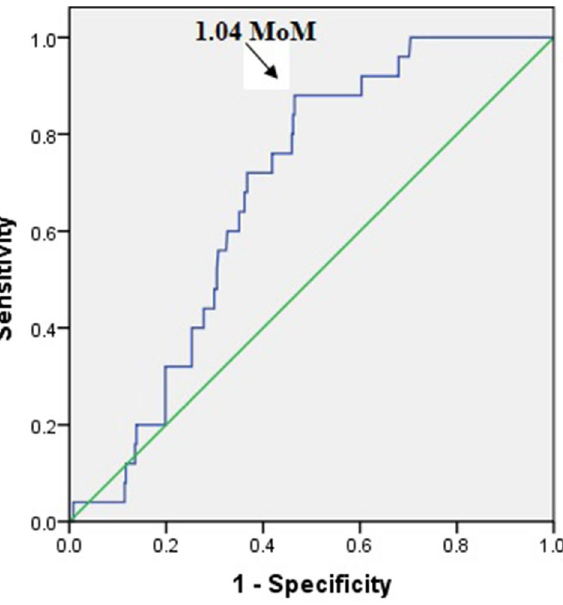
Figure 2. Receiver-operating characteristic curve for the relationship between serum high mobility group box-1 levels and diagnosis of preeclampsia (AUC 0.680; p = 0.003; 95% CI 0.604–0.757).